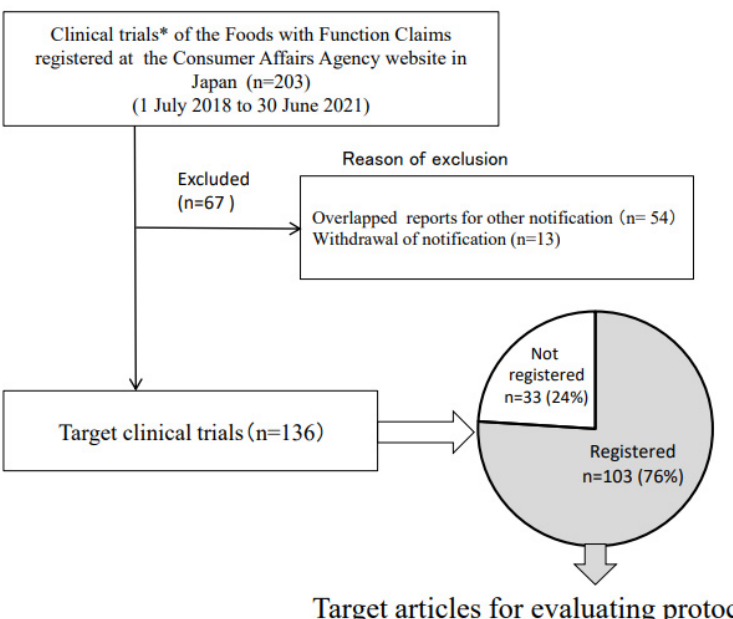
Figure 2. Flow of trial process and implementation status of clinical trial registration. * Number of notifications as Foods with Function Claims ( n = 177).